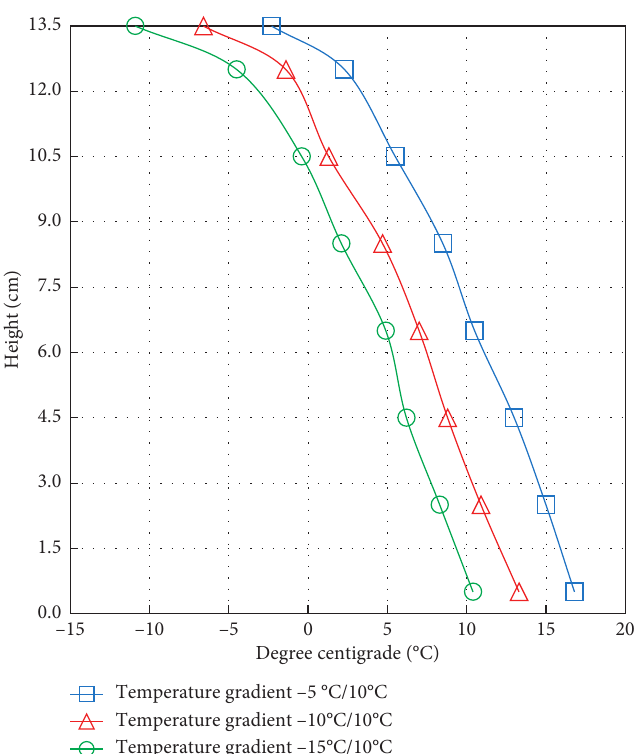
Figure 8: Measured temperature distributions of different temperature gradients.